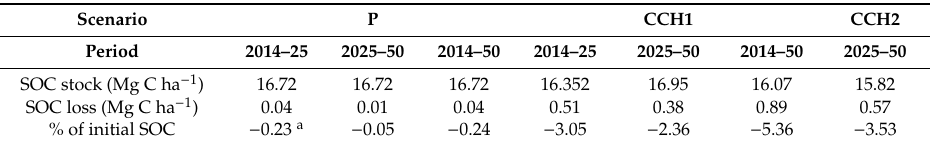
Figure 4. Simulated yearly SOC dynamics under three climate scenarios (P, CCH1 and CCH2). Table 4. Losses of SOC stock under three climate change scenarios (P, CCH1 and CCH2) from 2025 to 2050 in the arid rangelands of BandBast.